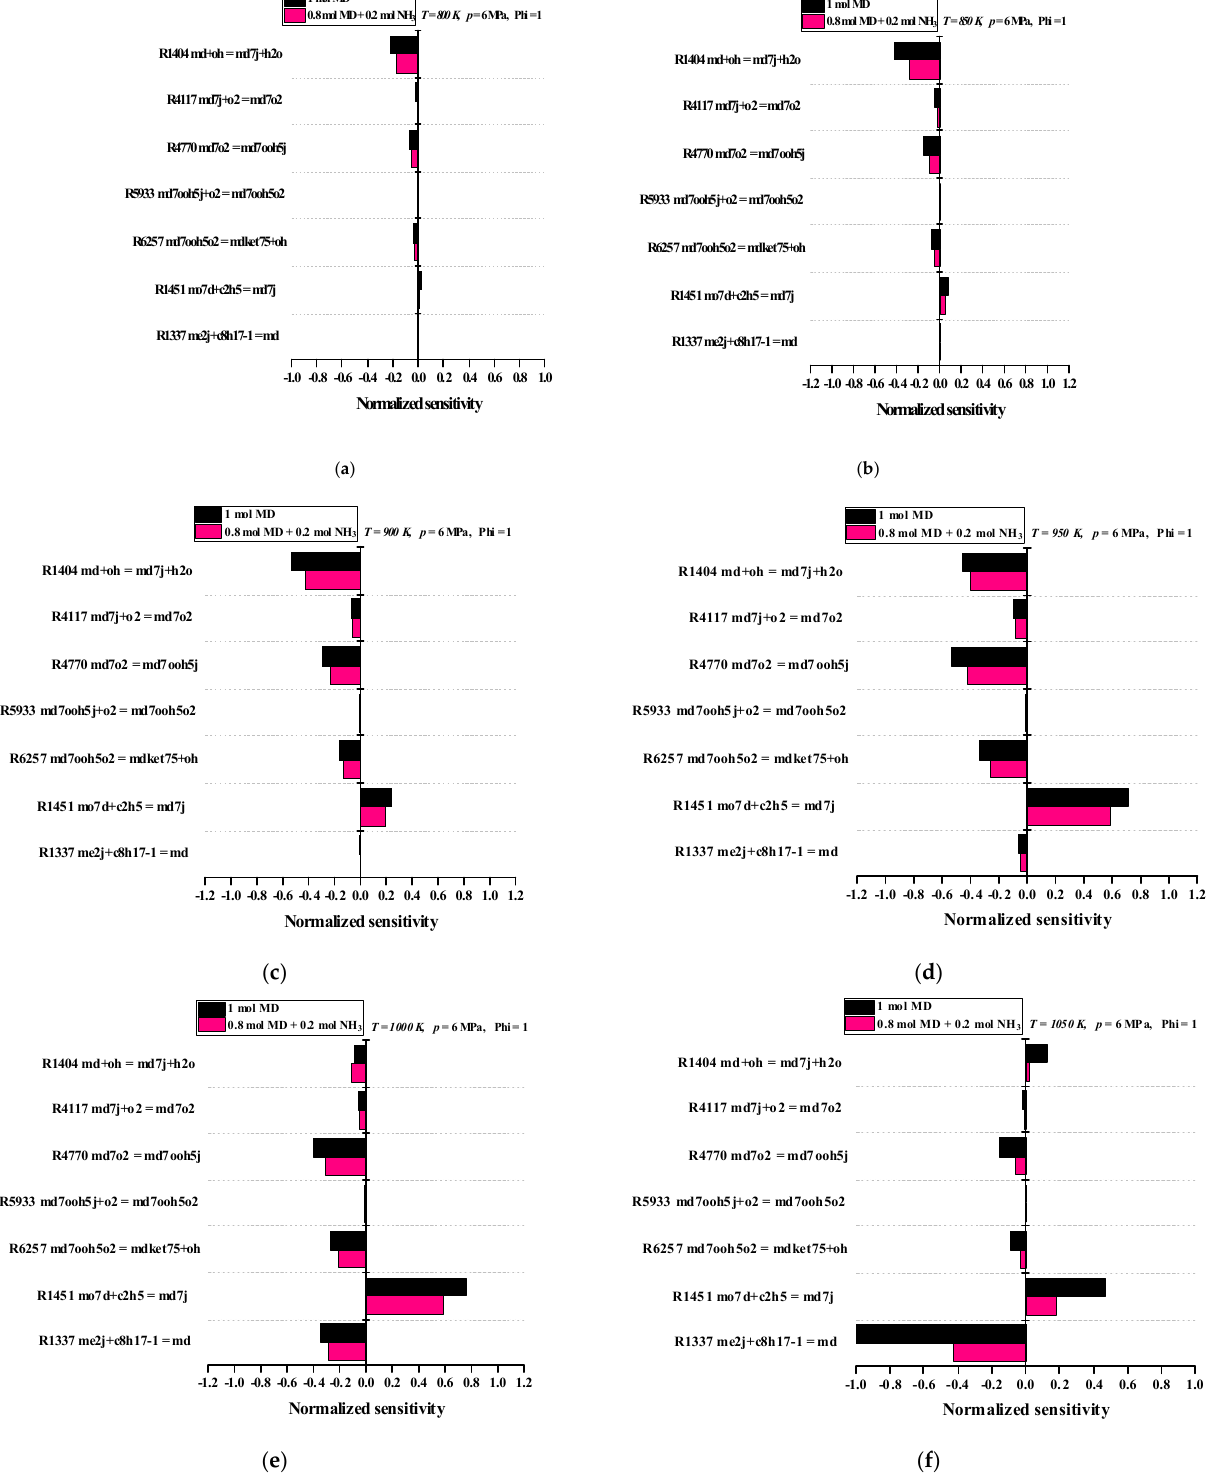
Figure 4. Sensitivity analysis of MD ignition and flame retardation with different moles of NH 3 under the conditions of initial temperature in the range of 800–1050 K and pressure of 1 MPa: ( a ) initial temperature at 800 K; ( b ) initial temperature at 850 K; ( c ) initial temperature at 900 K; ( d ) initial temperature at 950 K; ( e ) initial temperature at 1000 K; ( f ) initial temperature at 1050 K.